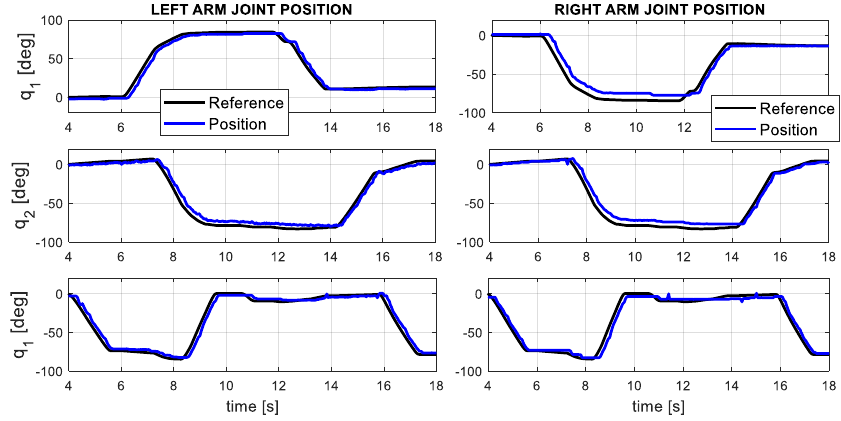
Figure 13. Evolution of the joint angles of the dual arm during the morphing transition.